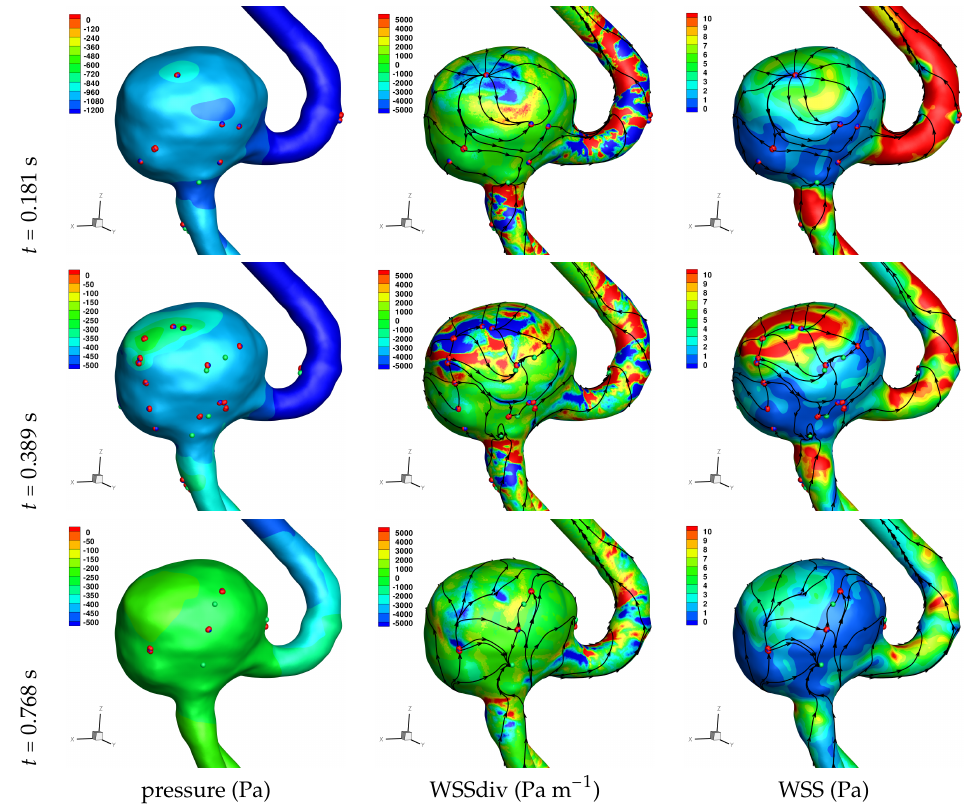
Figure 8. Solution for Case 5. Plots of surface shear lines and WSS critical points (colouring scheme as in Figure 3).